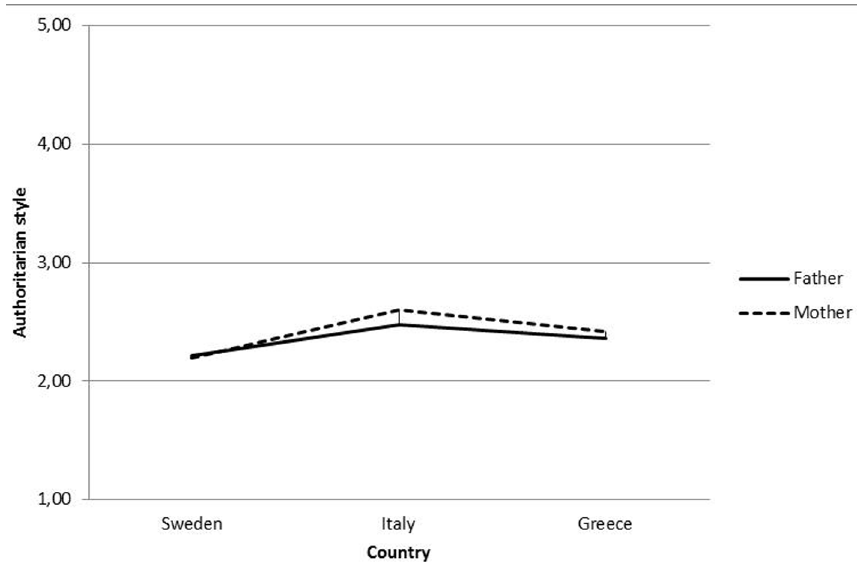
Figure 1. Interaction effect